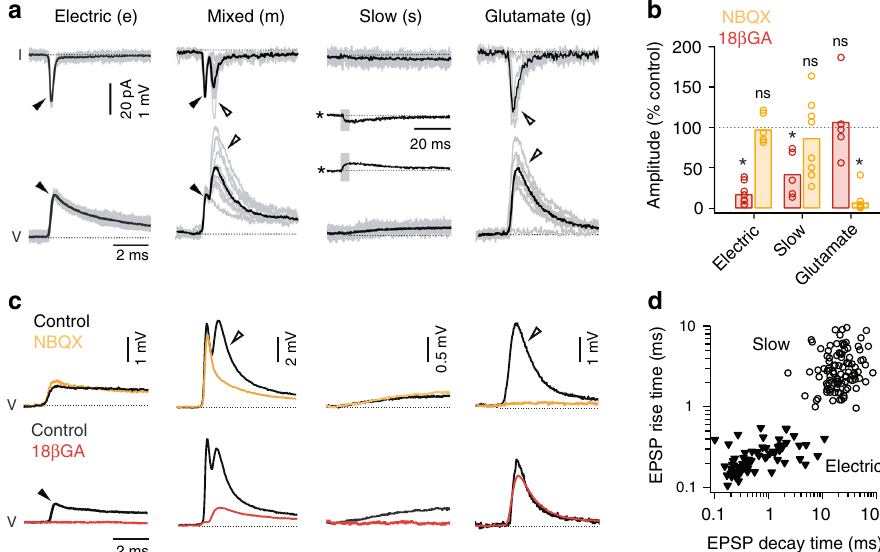
Fig. 4 V2a neurons exhibit diverse modes of synaptic connectivity. a Recordings of spike-triggered post-synaptic events in voltage-clamp (top row) and current-clamp (bottom row). Filled arrowheads mark electrical excitatory post-synaptic currents (EPSCs) and post-synaptic potentials (EPSPs), while open arrowheads mark glutamatergic EPSCs and EPSPs. Slow electrical EPSCs and EPSPs are also inset on a compressed time scale (asterisks), with a gray box indicating the expanded region above or below. Black lines are averages of successful events and gray lines are individual events, including failures where appropriate. I current, V voltage. b Quanti fi cation of the effect of drug treatment normalized to control EPSP or EPSC amplitudes for electric, glutamatergic (glut.) and slow responses. Electric 18 β GA (* signi fi cant following Student ’ s t -test, t(16) = 19.9, p < 0.001, n = 9); electric NBQX (ns, not signi fi cant following Student ’ s t -test, t(10) = 0.4, p = 0.711, n = 6); glutamatergic 18 β GA (ns, Student ’ s t -test, t(8) = 0.3, p = 0.772, n = 5); glutamatergic